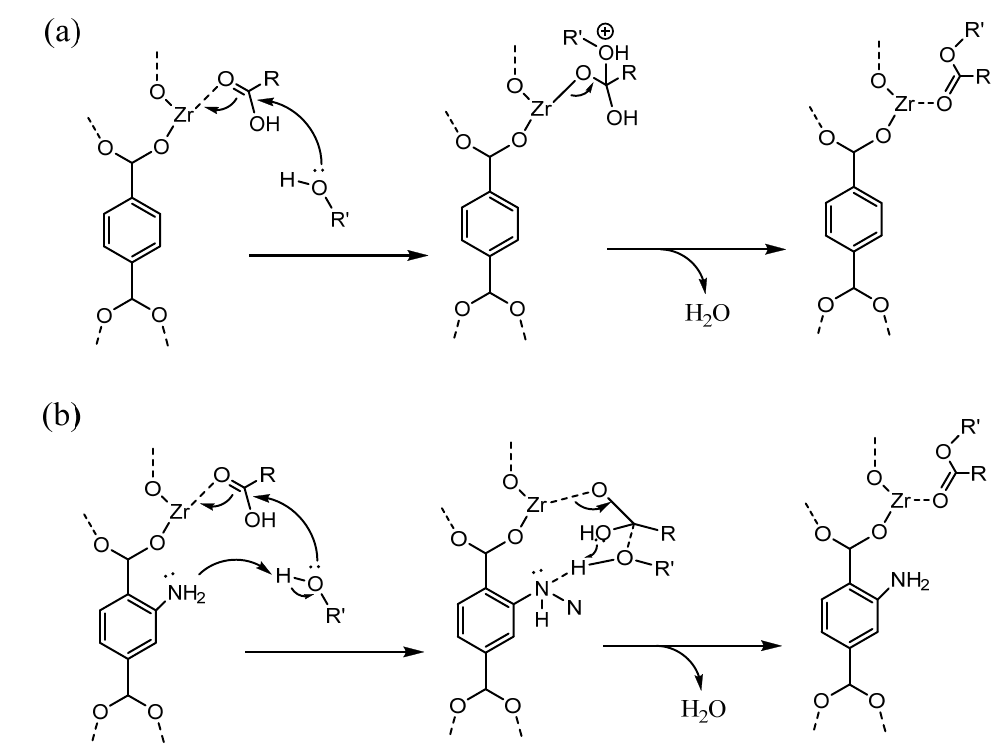
Figure 4. Plausible mechanisms for esterification: ( a ) UiO-66 catalyst; ( b ) UiO-66-NH 2 acid–base catalyst. (Adapted with permission from Ref. [34]. Copyright 2015, Elsevier.)